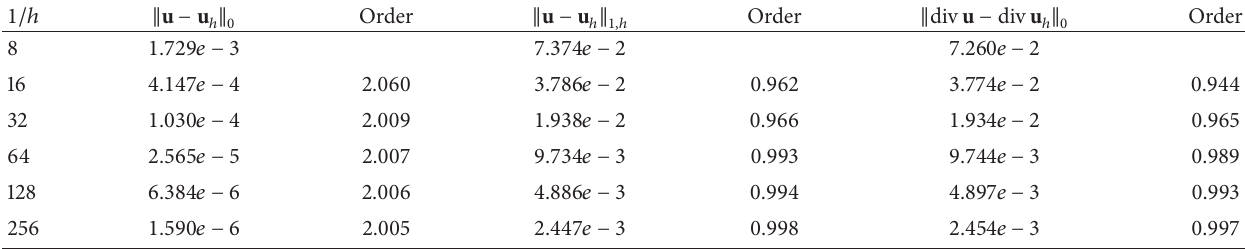
Table 2: 𝜇 − = 1 , 𝜇 + = 10 , and 𝜆 = 5 𝜇 .